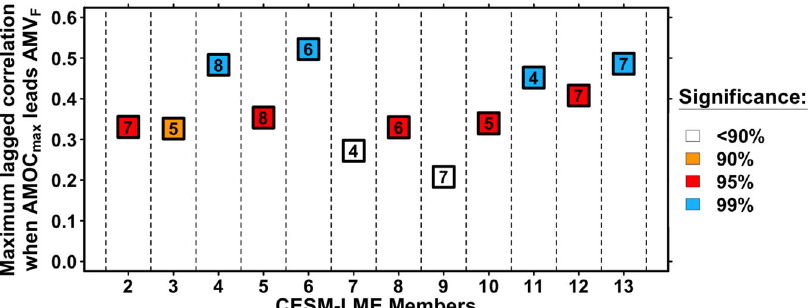
Fig. 5 | Maximum lagged correlations when the Atlantic Meridional Over- turning Circulation index (AMOC max ) leads the Atlantic Multidecadal Varia- bility index (AMV F ) index in 12 members of Community Earth System Model Last Millennium Ensemble (CESM-LME). Squares correspond to the maximum lagged correlation when AMOC max leads the AMV F index. Orange, red, and blue